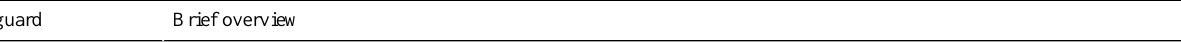
Table 5. Environmental safeguards installed in data centers. Brief